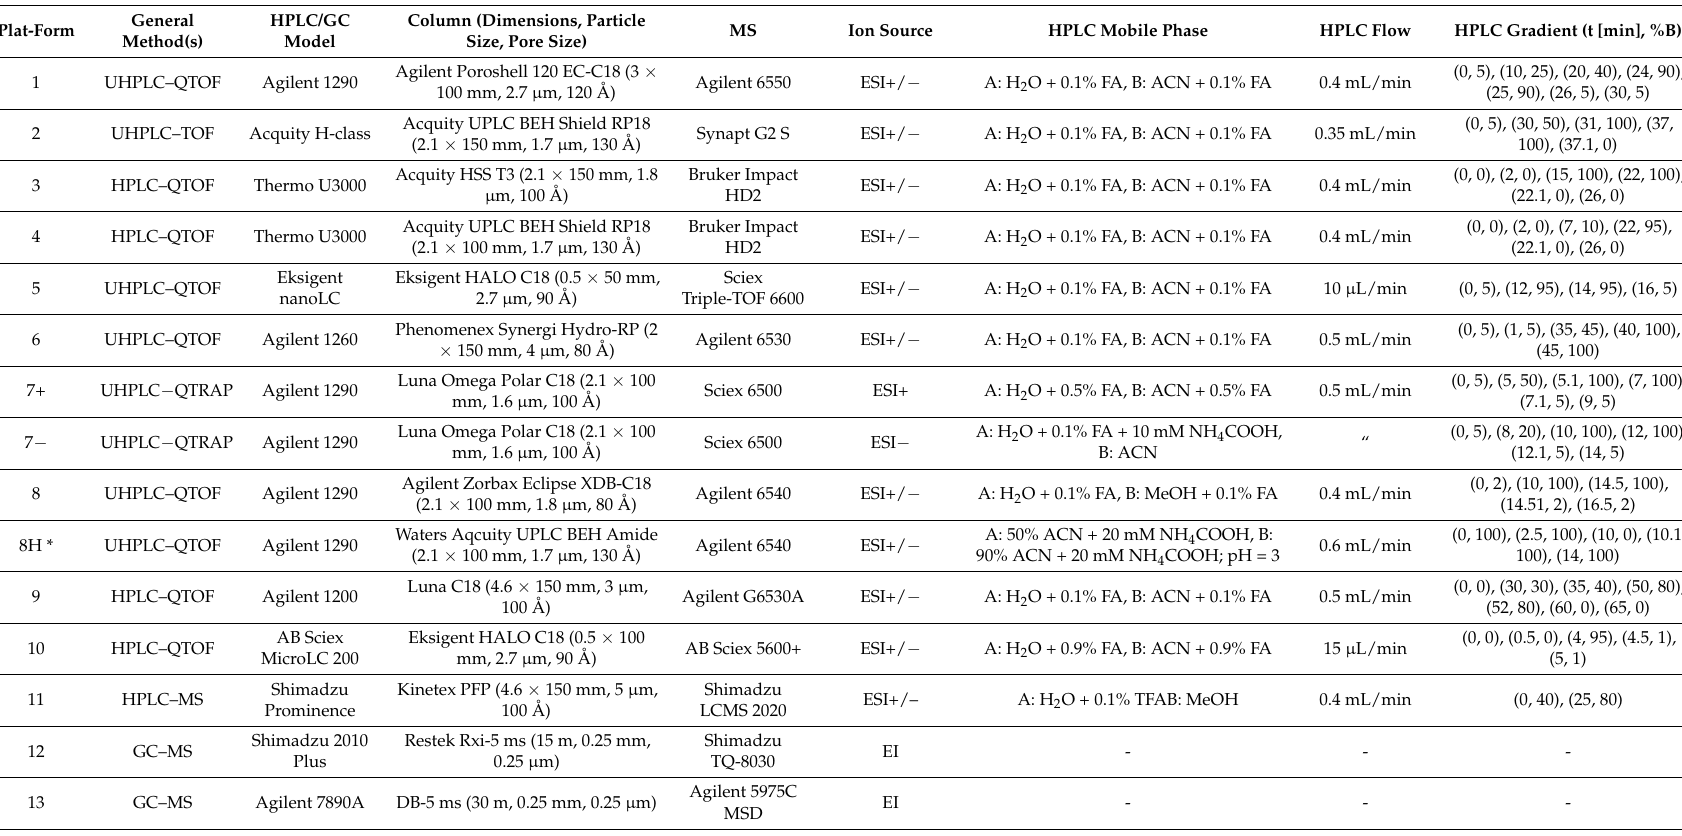
Table 1. Platforms that participated in the test with their equipment information and mass spectrometric and chromatographic conditions. ESI = electrospray ionization, EI = electron ionization, * hydrophilic interaction chromatography